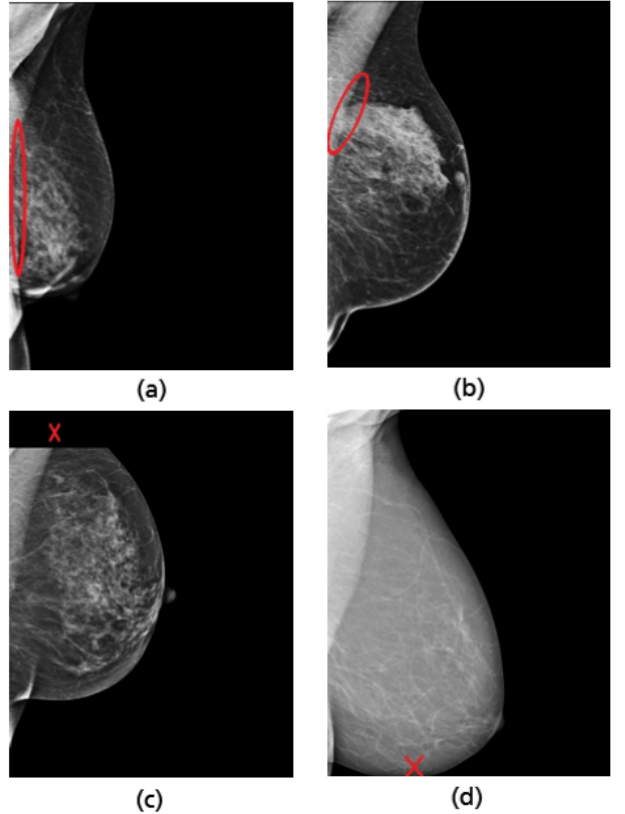
Figure 25. Examples of inadequately positioned MLO views. Retromammary tissue not fully visualized ( a , b ). Missing part of the axillary tail ( c ). Missing part of the lower breast quadrant ( d